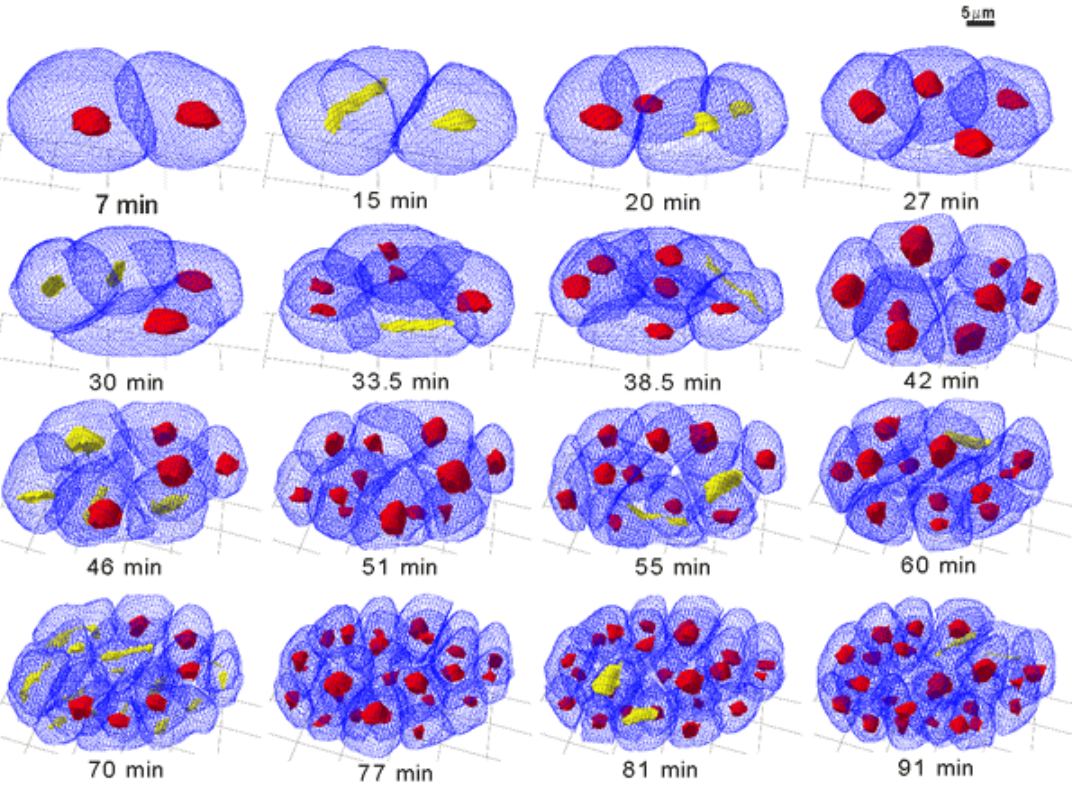
FIGURE 8 . 3D-DIAS faceted reconstructions of the developing C. elegans embryo between 7 min (2 cell) ad 91 min (26 cell) of development. Cell surfaces are transparent blue faceted images, interphase nuclei red images and mitosing nuclei yellow images (see [54] for